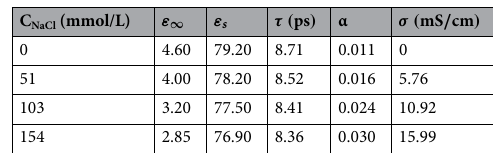
Table 1. Extracted Cole–Cole model parameters for sodium chloride/water